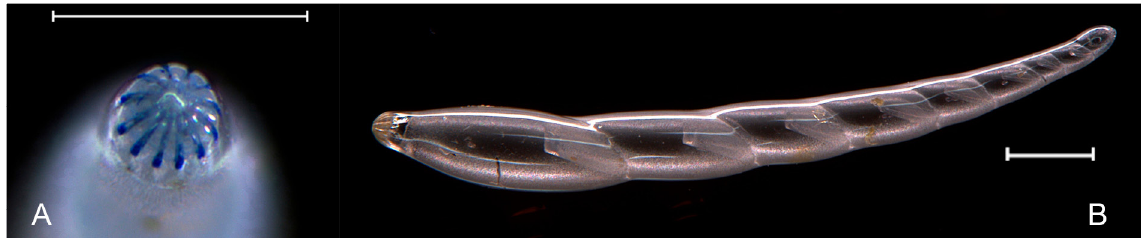
Fig. 4. Dentalina filiformis (d’Orbigny, 1826). A–B . Megalosphere (BIOICE 3600, IINH 40457), side view (B) and aperture (A) stained with indigo blue. Scale bars = 0.25